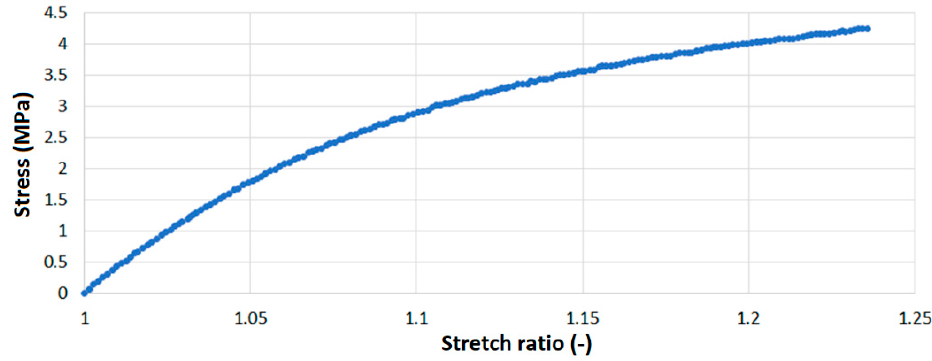
Figure 7. Stress dependence on the stretch ratio for material TPU 30D.